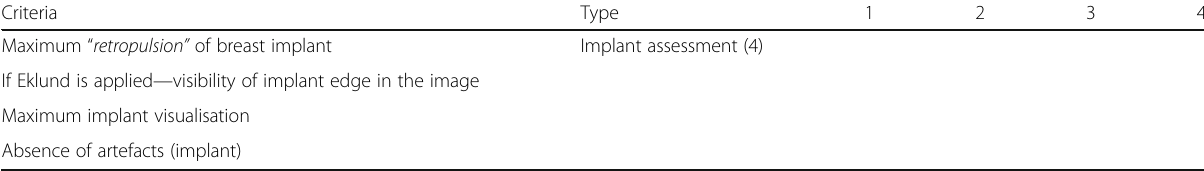
Table 2 Criteria designed to assess the implant imaging in craniocaudal, mediolateral oblique and mediolateral mammograms Criteria Maximum “ retropulsion ” of breast